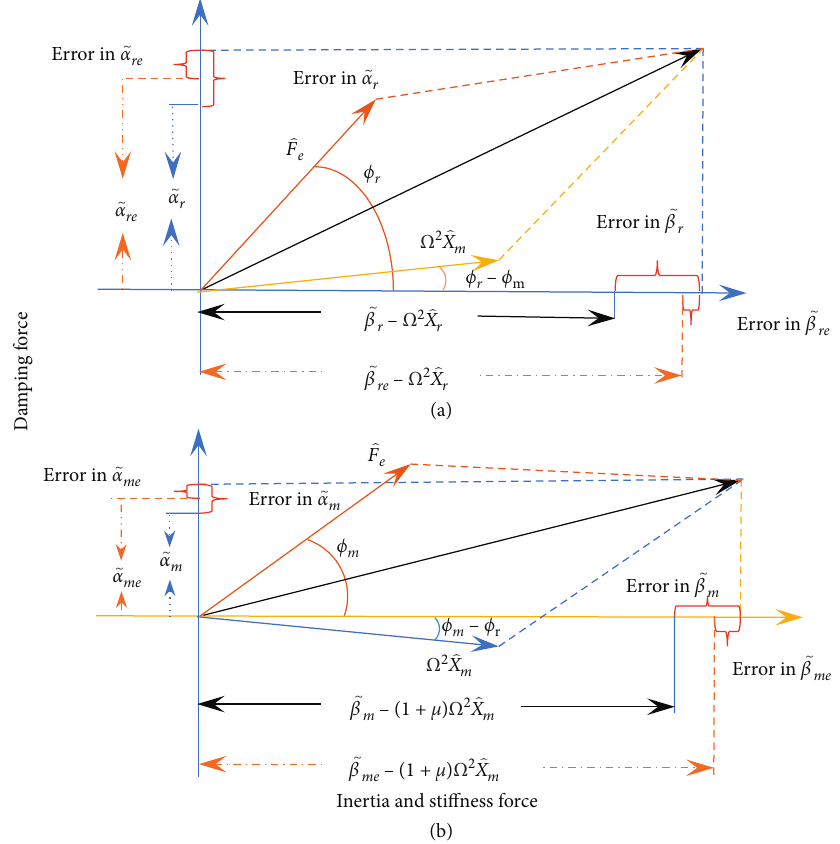
Figure 2: The orthogonal relationship between force